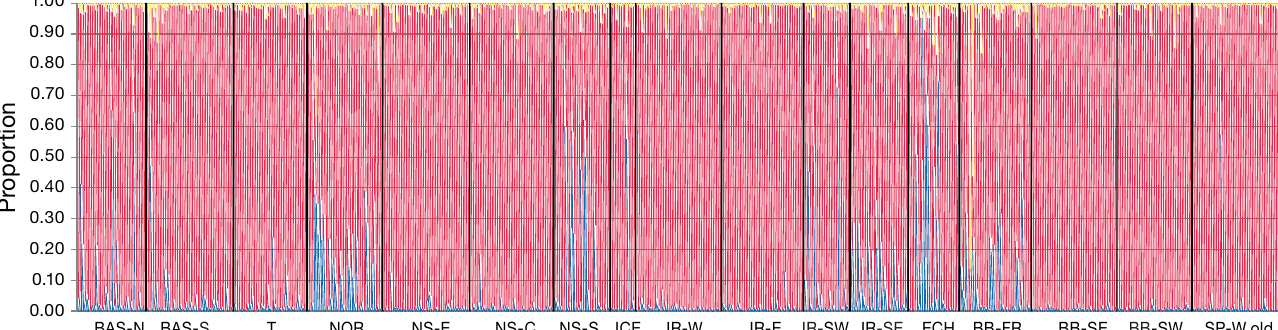
Fig. 5. STRUCTURE results for all wild samples of turbot genotyped for the whole panel of 755 SNPs. Data shows 3 population units ( K) corresponding to the 3 reference samples (red: _ W _ATL , yellow: F _ORI1 , blue: F _ORI2 ). See Fig. 2 legend for description of